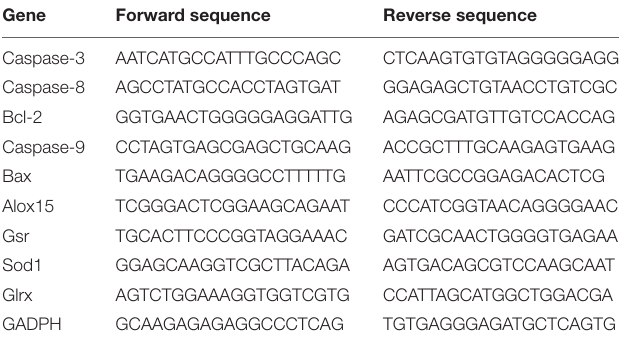
TABLE 1 | PCR sequences used in the